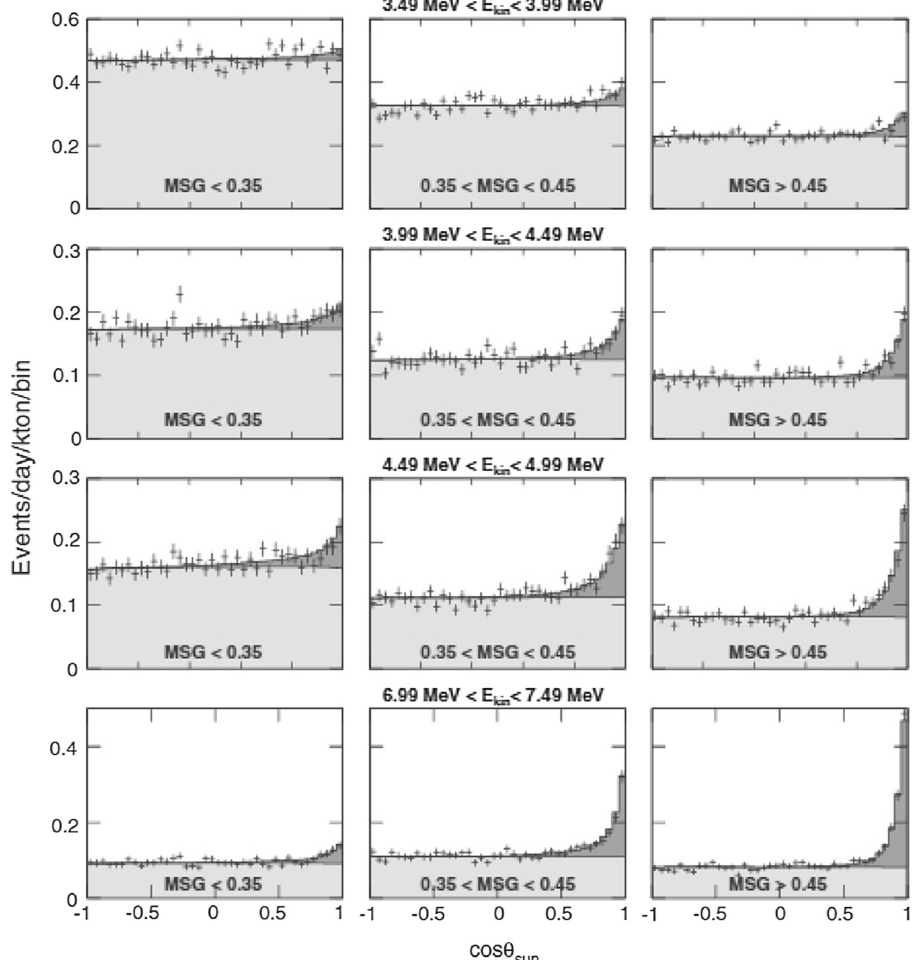
Fig. 12 Directional distribution of the solar neutrinos observed in Super-K shown below 7.5 MeV [64]. The event discrimination algorithm (MSG) works even in low energy regions down to 3.5 MeV making recoil electron peaks prominent from